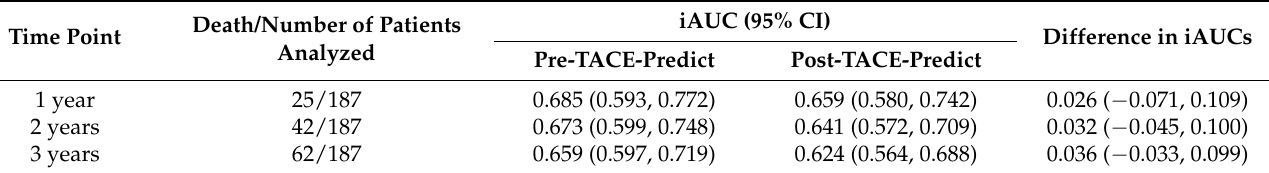
Table 5. Comparison between Pre- and Post-TACE-Predict models.